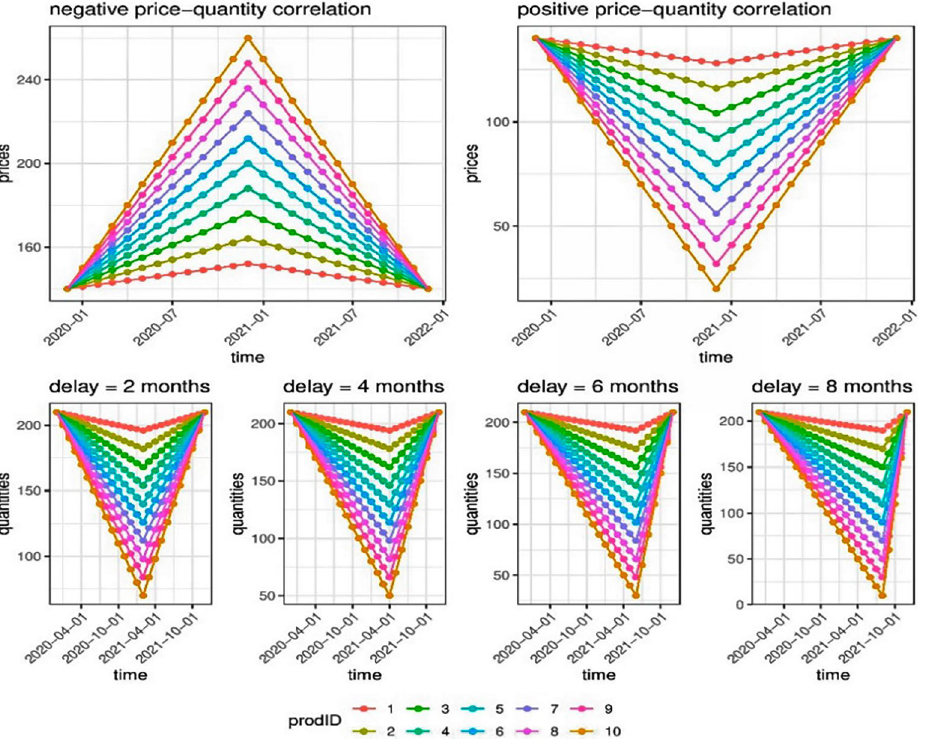
Figure 2. Price and quantity processes for ten considered products depending on the price-quantity correlation and the level of delay in consumer